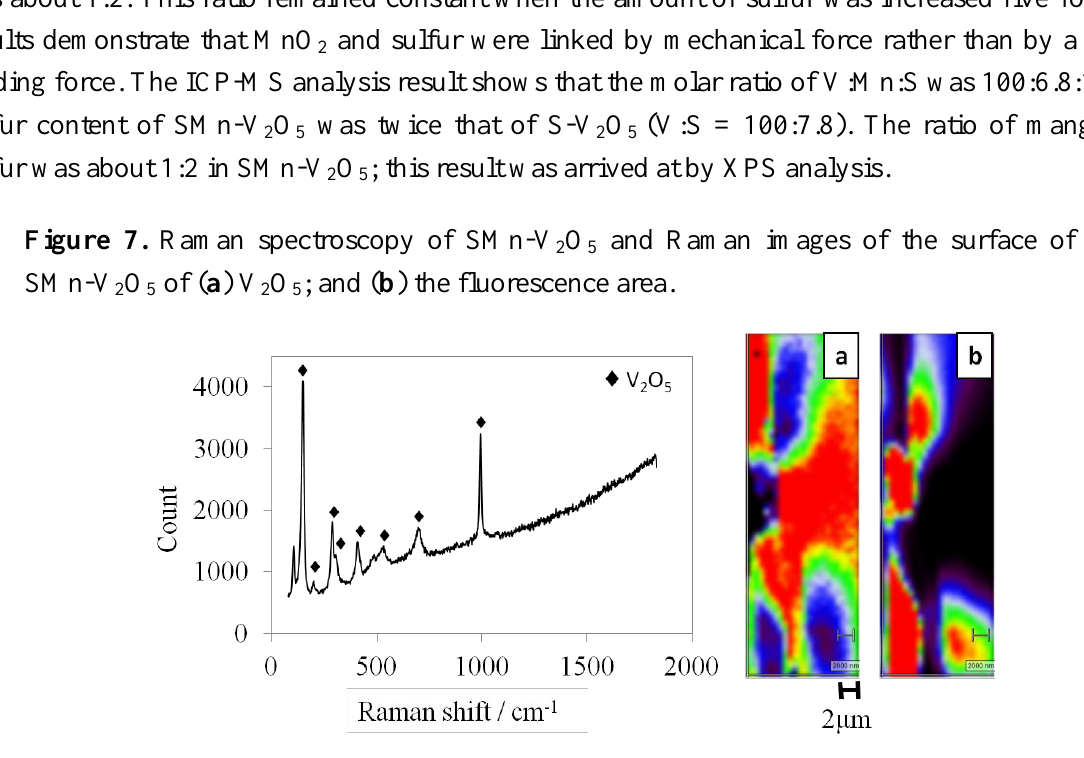
O and Raman images of the surface of the 2 5